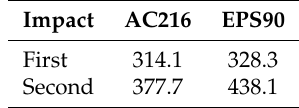
Table 8. Peak accelerations measured for each liner